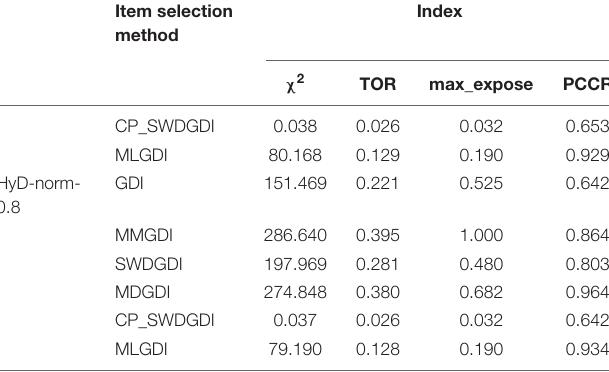
TABLE 5 | Item exposure of each item selection method for five